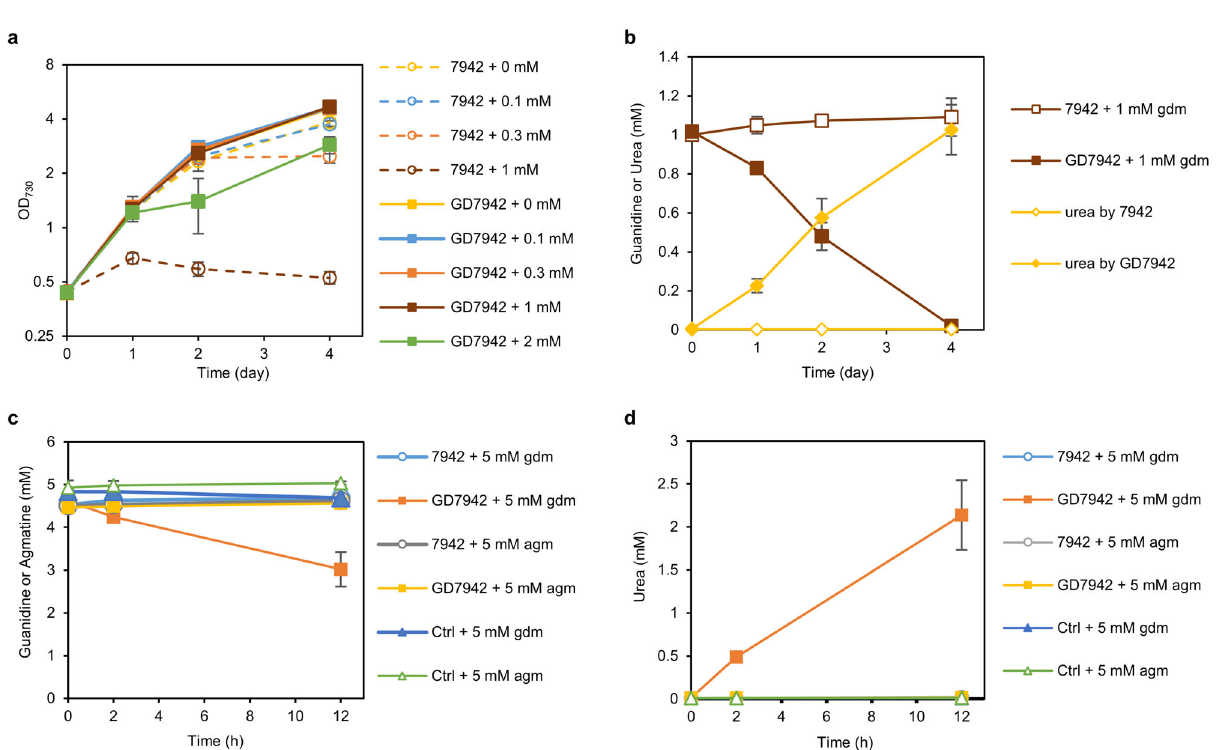
Fig. 5 Expression of sll1077 improves the tolerance of Synechococcus 7942 to guanidine. a Cell growth curves for the Synechococcus 7942 and GD7942 ( + sll1077 ) grown with various concentrations of exogenous guanidine in the mBG11 medium supplemented with 50 mM bicarbonate. b Time courses of guanidine and urea concentrations in the culture supernatants of Synechococcus 7942 and GD7942 grown with 1 mM guanidine. c Concentrations of guanidine or agmatine in the enzymatic reaction mix along the time course. Either 5 mM guanidine (gdm) or agmatine (agm) was incubated with cell extract of Synechococcus 7942 or GD7942. Control (Ctrl) included all the components but the cell extract. d Production of urea by the cell extract of Synechococcus 7942 or GD7942 incubated with 5 mM guanidine (gdm) or agmatine (agm). All measured urea concentrations were close to zero except for ‘ GD7942 + 5 mM gdm ’ . Data represent means and standard deviations from three biological replicates. Source data are provided as a Source Data fi